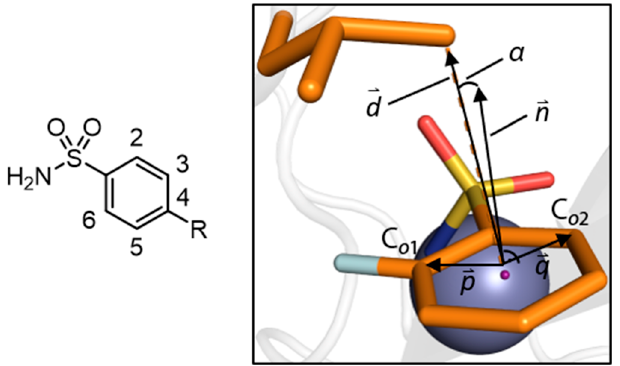
Figure 1. Derivation of metrics listed in Table1 and used for calculations. Calculation of α and the meaning of quantities depicted here and used in the process are described in Materials and Methods.